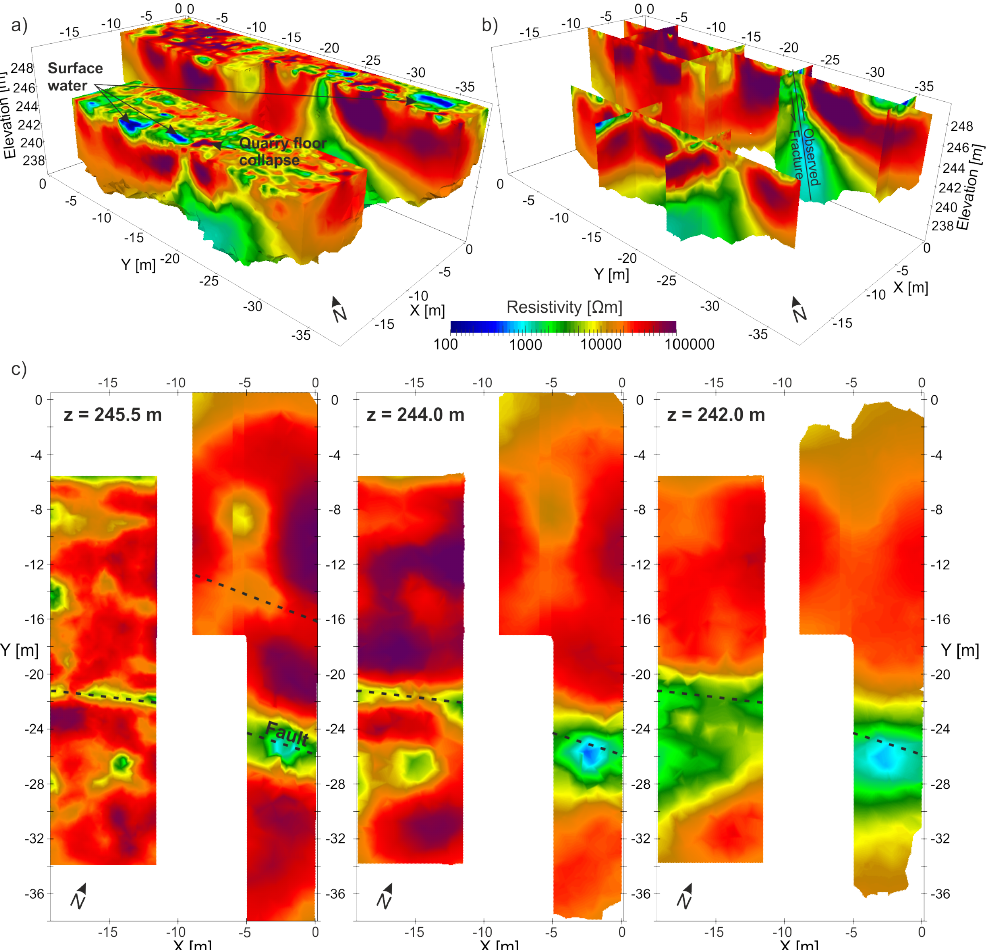
Figure 8. Inverted resistivity model; the RMS misfit between modelled and measured data is RMS = 2.1%. ( a ) Surface plot, ( b ) fence diagram, ( c ) horizontal slices; the model shows the resistivity distribution in the actual survey areas. Cells with sensitivities < 5 × 10 − 3 were removed. Note the resistivity color range, which spans 100 to 100,000 Ω · m. The maximum resistivity in the model exceeds this range at 580,000 Ω · m. Features representing surface water accumulation, the clay-lined fracture, and cave outline are apparent; field observations of faults are shown as dashed